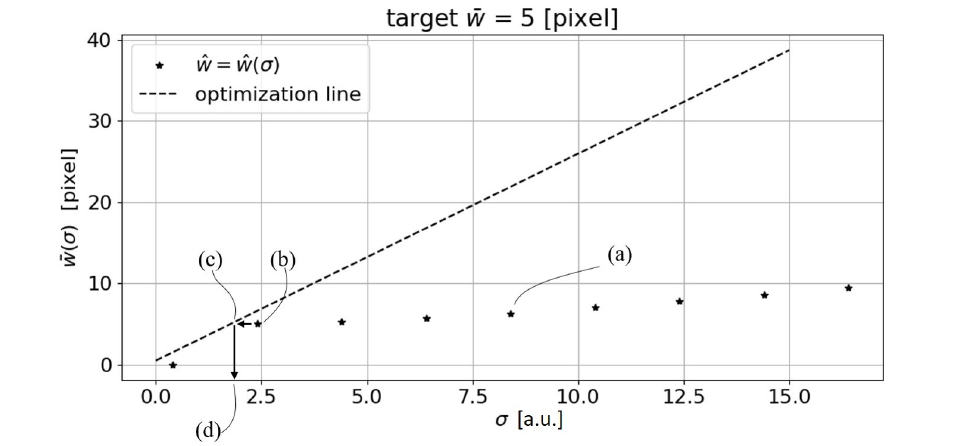
Figure 14. Example of sigma optimization technique application. (a.u.: arbitrary unit). After all necessary ( σ , ¯ w ) (a) are calculated, starting from the point ( σ ∗ , ¯ w ∗ ) (b), an horizontal line is drawn up to the optimization line (c). The σ value corresponding to the intersection of this horizontal line with the optimization line represents the σ opt value